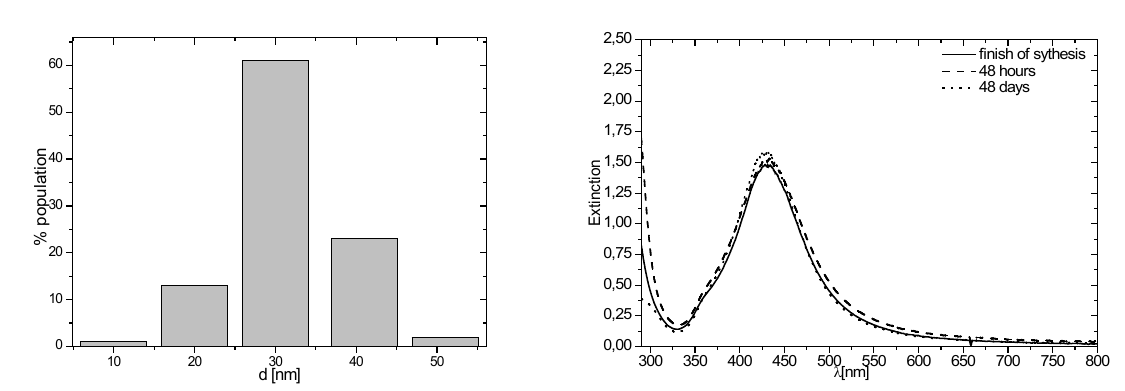
Figure 12. UV-Vis spectra of silver nanoparticles water suspension recorded after one hour, after 48 hours and after 48 days following the start of the synthesis.